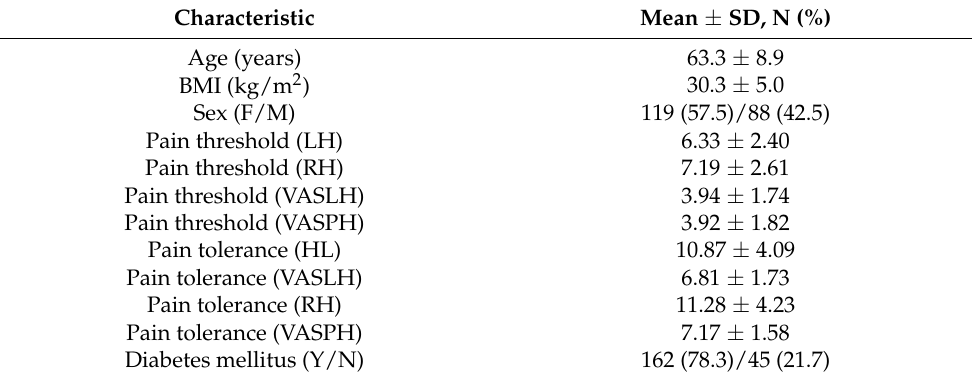
LH—left hand, RH—right hand and VAS—visual analog